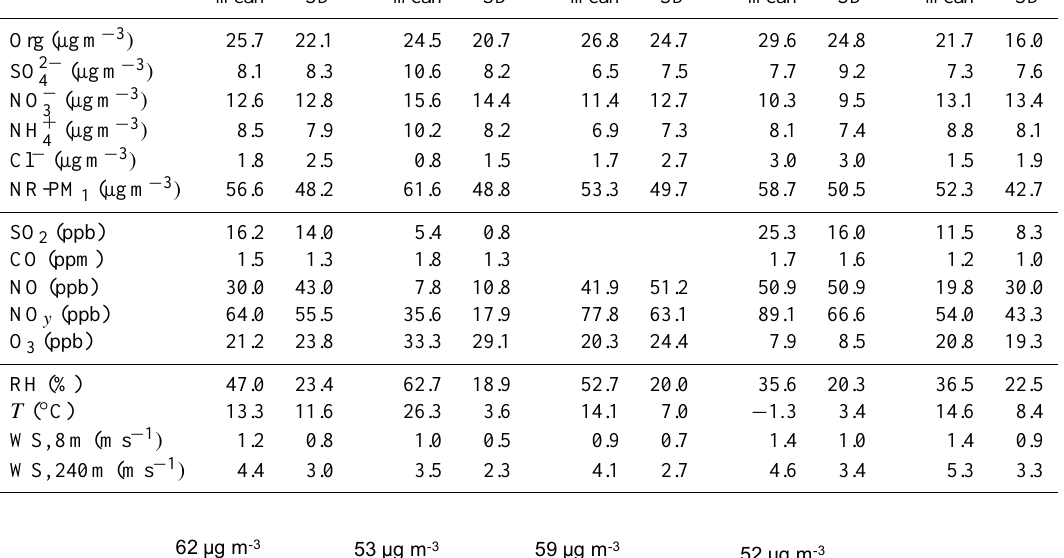
Table 1. Summary of mass concentrations of NR-PM 1 species, gaseous pollutants and meteorological parameters during the four seasons and entire study period. Entire study Summer Fall Winter Spring